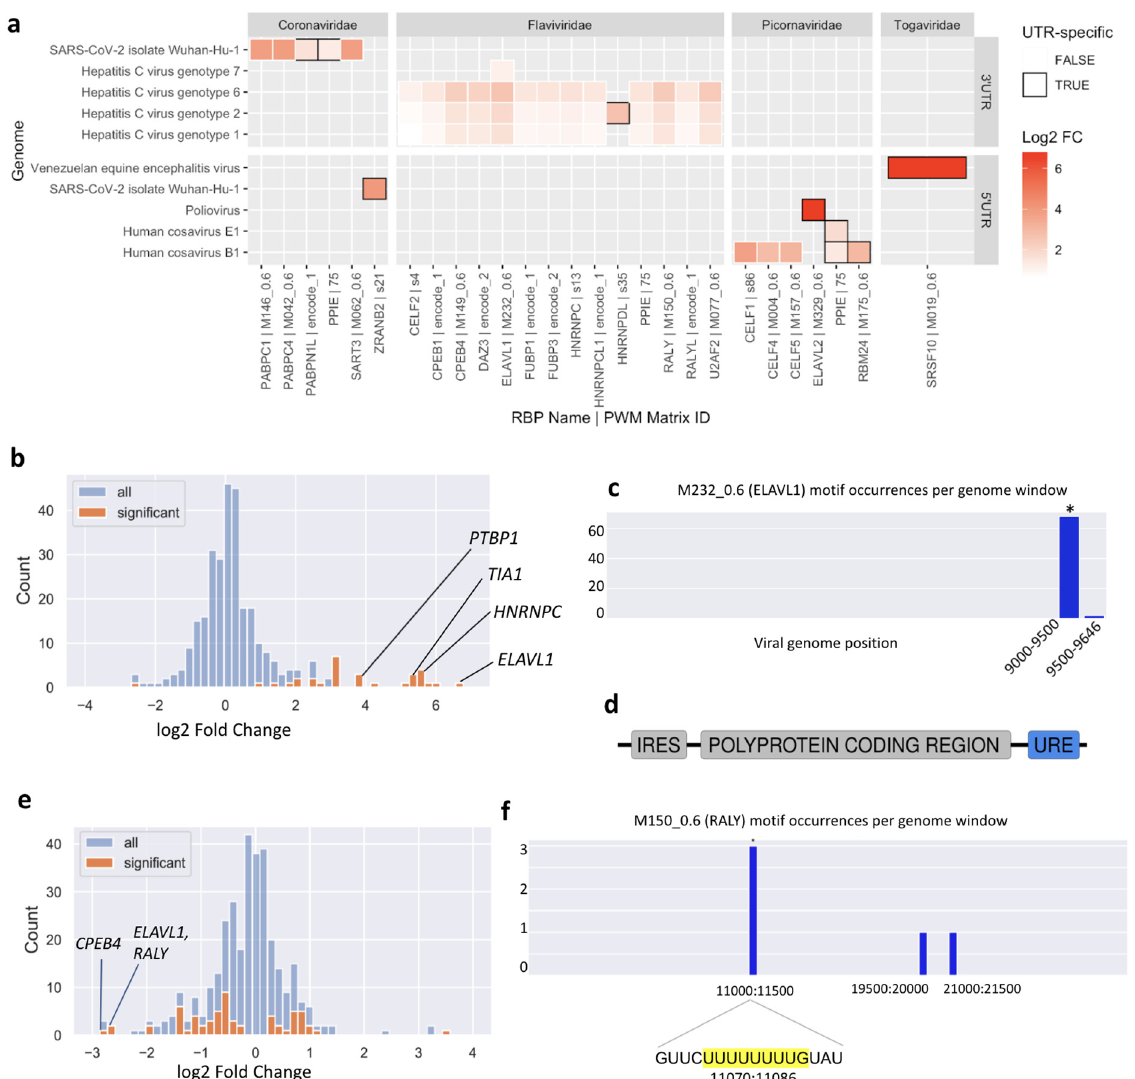
Figure 4. Motif enrichment patterns in specific regions of viral genomes. ( a ) UTR enrichment/depletion analysis results from SMEAGOL. Cells with black frames represent motifs that were not significantly enriched in the whole genome. Only representative motifs (see Methods) were included in this figure. Full results are given in Supplementary Data S4. ( b ) Motifs for 22 RBPs were predicted by SMEAGOL to be significantly enriched within the HCV genome while one motif was de- pleted (shown are the results for HCV genotype 1a). ( c ) Using the local window enrichment function of SMEAGOL (see Methods), we found that the vast majority of regions lack binding motifs for the ELAVL1 RBP, whereas it was highly enriched (marked by an asterisk) within a region at the 3 (cid:48) end of the HCV genome (Two-sided Fisher’s exact test, odds = 21.8, FDR-adjusted p -value = 1.4 × 10–51). ( d ) A U-rich element (URE) is located within the 3 (cid:48) UTR of the HCV genome [32]. ( e ) RBPs pre- dicted by SMEAGOL to be significantly enriched/depleted in binding sites within the SARS-CoV-2 genome. URE-binding RBPs are shown to be most strongly depleted. ( f ) Using the local window enrichment function of SMEAGOL, we observed that binding motifs of RALY are absent in most of the SARS-CoV-2 genome but enriched in a specific region (Two-sided Fisher’s exact test, odds = 36.5, FDR-adjusted p -value = 0.013). On closer inspection, this is due to multiple motifs within an URE at position